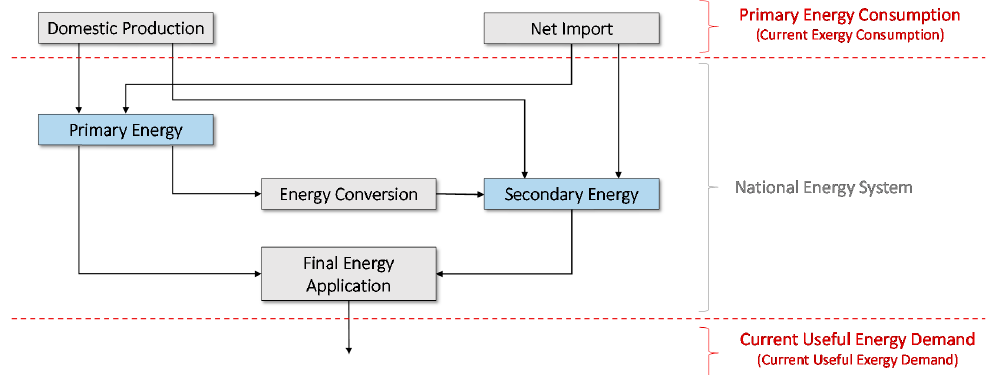
Figure 5. Schematic visualization of a general national energy system, including the energy flows into and out of the system (red). All energy flows into the system are called primary energy consumption. The flow out of the system is the current useful energy demand.